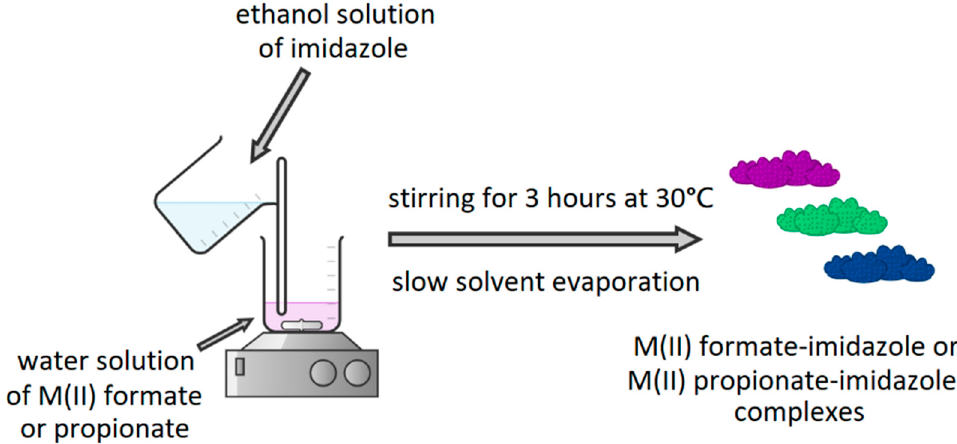
Figure 2. Synthesis of M(II) formate-imidazole or M(II) propionate-imidazole complexes.